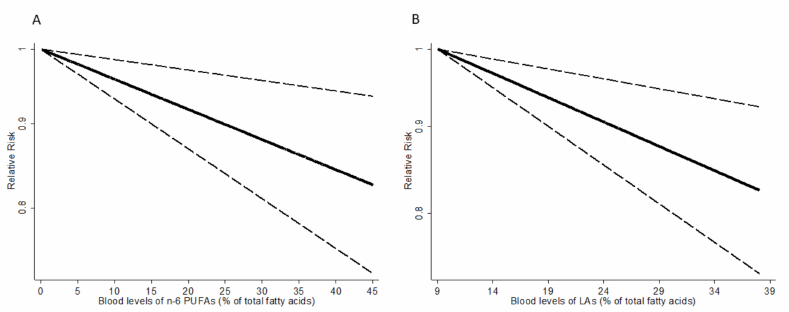
Figure 3. Dose-response association between blood levels of n-6 PUFAs ( A ), LA ( B ) and relative risk of cancer. The vertical axis is on a log